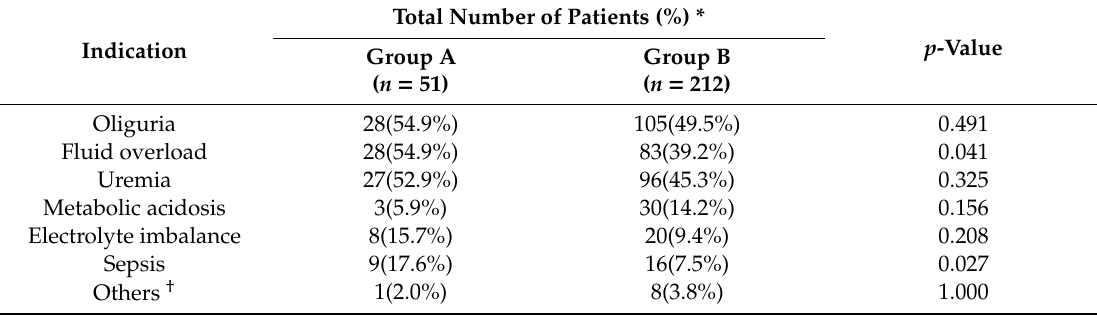
Table 3. Indications of initiating CRRT.